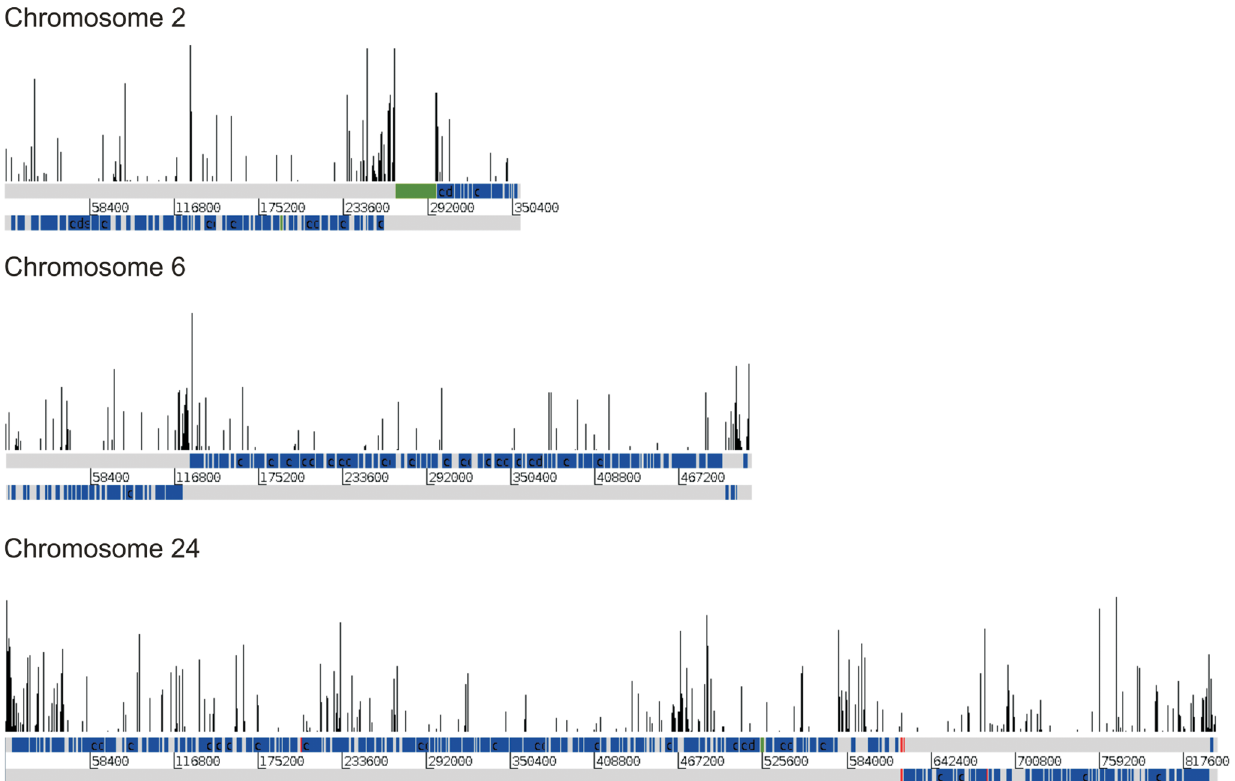
Figure 1. Graphical representation of IC peaks on selected L.major chromosomes. Bar plots of IC positions with an IC value greater than 9 degrees per helical turn. Both DNA strands are depicted in grey below bar plots, overlaid with CDS features shown in blue. Features labeled as ncRNA, snRNA or snoRNAs are shown in green. tRNAs are shown in red.